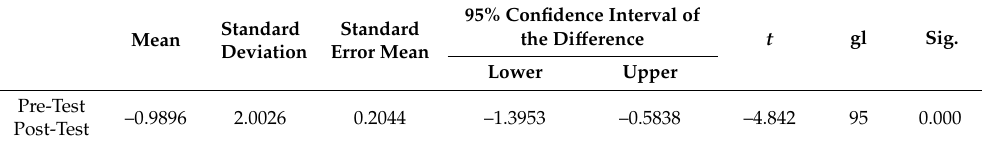
Table 4. t -student test for related samples of pre-test and post-test data in Kindergarden.